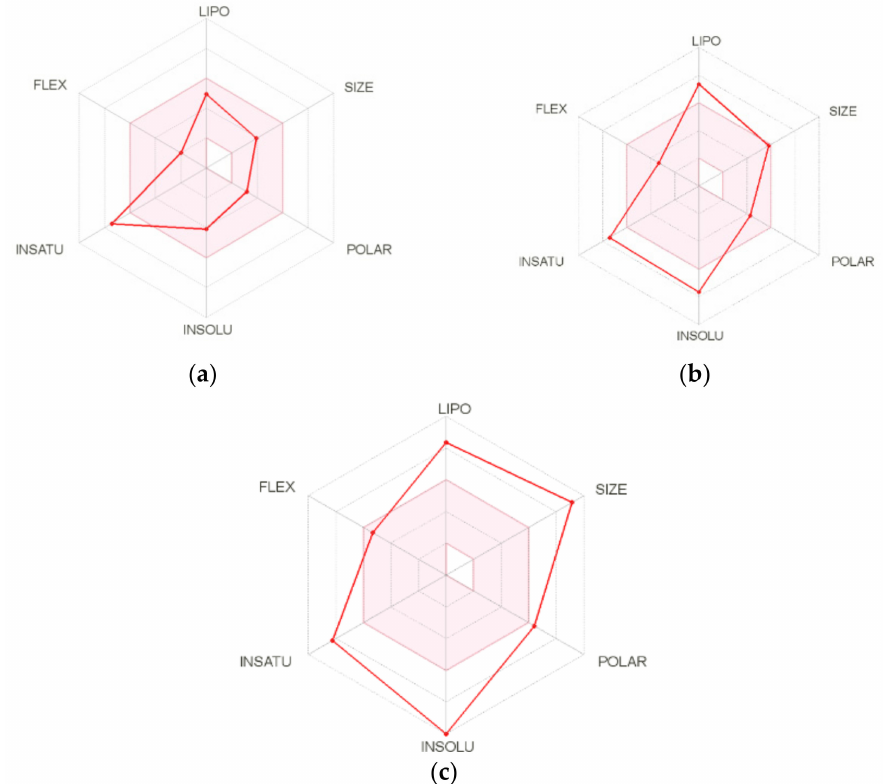
Figure 7. Bioavailability radar for ( a ). C15, ( b ). ( 1 ) and ( c ). ( 4 ). (lipophility (LIPO) are within the range − 0.7 < XlogP3 < +5.0; molecular weight (SIZE) is 150 g/mol < MW < 500 g/mol; polarity (POLAR) is 20 Å 2 < TPSA < 130 Å 2 ; insolubility (INSOLU) is 0 < logS < 6; – insaturation (INSATU) are 0.25 < Fraction Csp3 < 1; and Flexibility (FLEX) are 0 < Num. rotatable bonds <